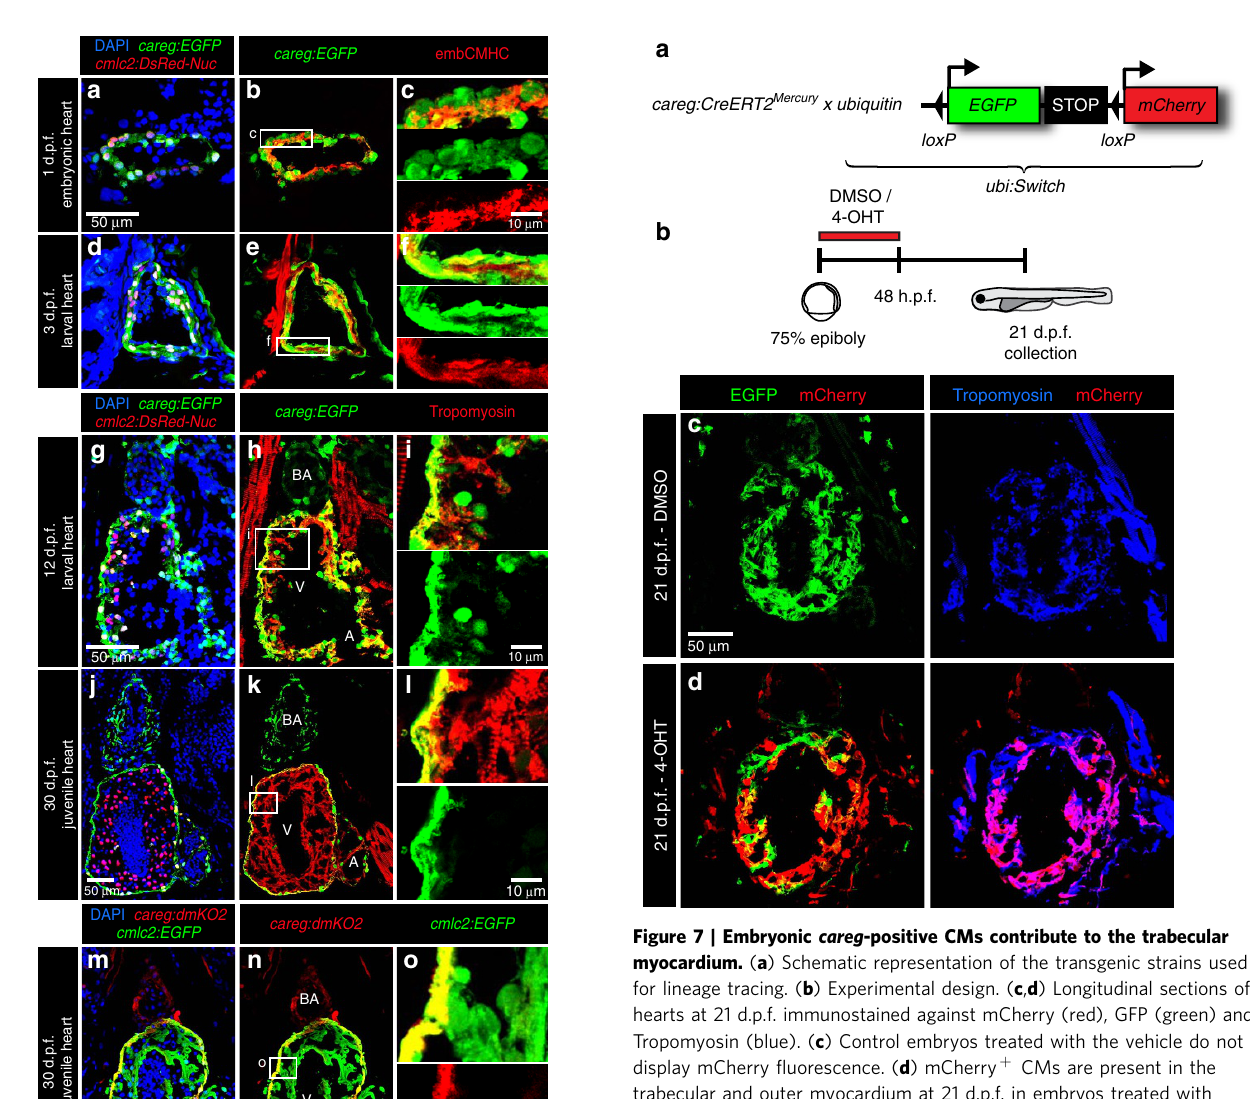
the bulbus arteriosus (BA) and a few cells of the atrium (A). ( m – o ) Longitudinal sections of careg:dmKO2;cmlc2:EGFP transgenic heart at 30 d.p.f. immunostained for GFP (green) and dmKO2 (red). The careg:dmKO2 transgenic line has a cardiac developmental expression pattern similar to that of careg:EGFP (Supplementary Fig. 10). N Z